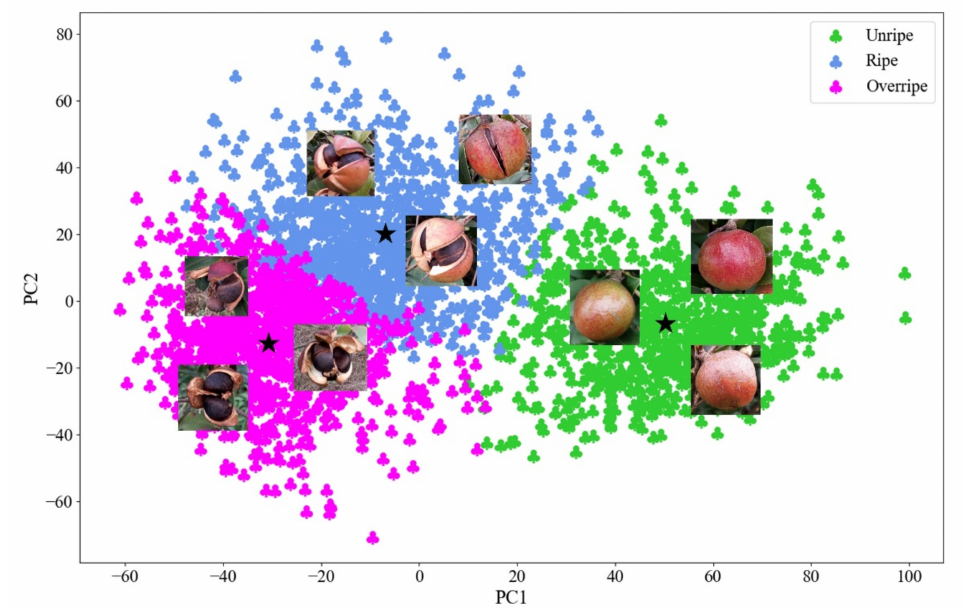
Figure 4. The maturity grading results of the training set. Here, the black pentagram represents the center of each maturity stage, and the Camellia oleifera images represent the fruit samples of each maturity